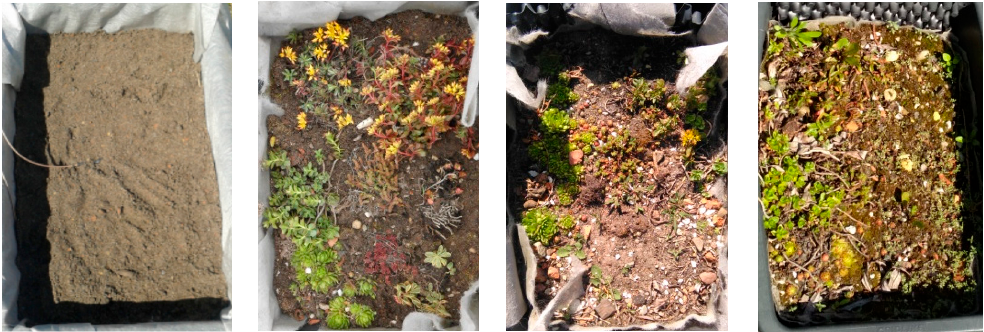
Figure 1. Long-term open air green roof experiment. Photos (from the left): first year (2013)—bare substrate; June 2015—model planted with Sedum plants; images from 2016 to 2017 (fifth year)—shows poor development of plant cover.